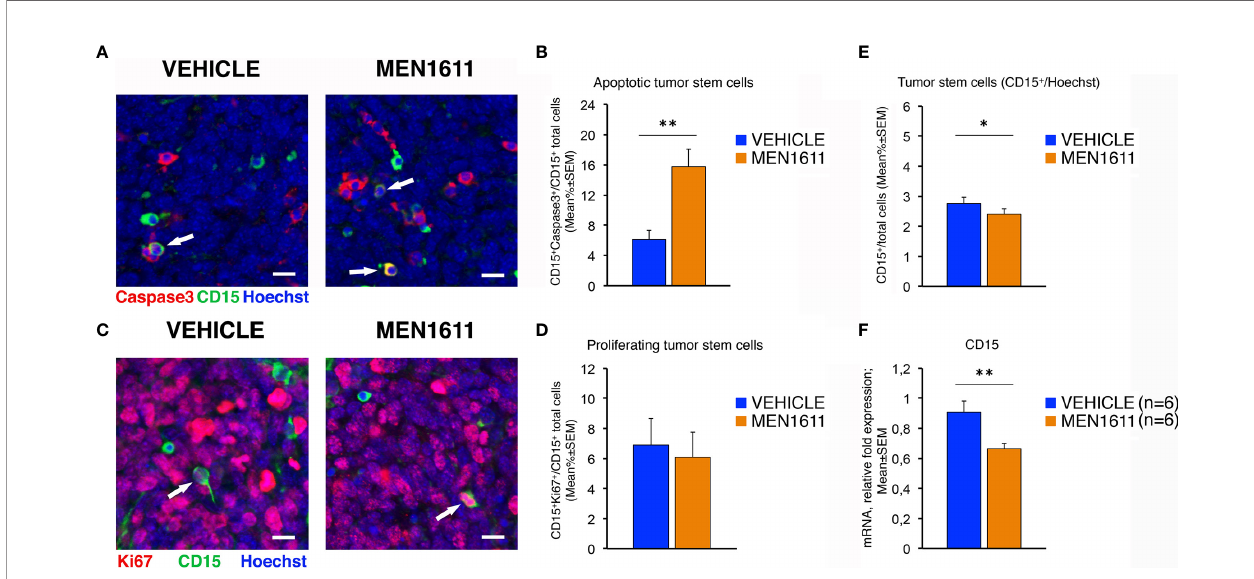
FIGURE 8 | In Ptch1 +/ − /Tis21 KO MB allografts, the treatment with MEN1611 induces the apoptosis of tumor stem cells. (A) Representative confocal images of secondary tumors from Ptch1 +/ − /Tis21 KO MB allograft treated with MEN1611 or vehicle, labeled with cleaved Caspase-3 (red) and CD15 (green) markers, and the nuclei dye Hoechst (blue). The apoptotic tumor stem cells (CD15 + Caspase3 + ) are indicated by white arrows. Scale bar, 10 m m. (B) Apoptotic tumor stem cells in the nodules of MEN1611-treated and vehicle-treated mice were quanti fi ed as mean ± SEM percentage ratio between the number of CD15 + Caspase3 + cells and the total number of CD15 + cells. ** p < 0.01, Mann-Whitney U -test. Mice analyzed: n = 6 for each treatment; fi elds analyzed: n = 144 for vehicle and n = 145 for MEN1611. (C) Representative confocal images of staining of MEN1611-treated and vehicle-treated nodules for Ki67 (red) and CD15 (green) markers. Nuclei were stained with Hoechst 33258. The proliferating tumor stem cells (CD15 + Ki67 + ) are indicated by white arrows. Scale bars: 10 m m. (D) Quanti fi cation of the percentage ratio (mean ± SEM) of CD15 + Ki67 + cells to the total number of tumor stem cells (CD15 + ) in nodules of MB allograft treated with MEN1611 or vehicle. p = 0.7346, Student ’ s t test. Mice analyzed: n = 6 for each treatment; fi elds analyzed: n = 134 for vehicle and n = 146 for MEN1611. (E) Quanti fi cation of the tumor stem cells, identi fi ed as CD15 + (green), in nodules of mice treated with MEN1611 or vehicle, measured as mean ± SEM percentage ratio between the number of CD15 + cells and the total number of cells (Hoechst-positive). The CD15 + cells were counted both in tumor slices reacted with the antibodies against Caspase-3 and CD15 (A) , and in sections labeled with Ki67 and CD15 markers (C) . * p < 0.05, Mann-Whitney U -test. Mice analyzed: n = 6 for each treatment; fi elds analyzed: n = 278 for vehicle and n = 291 for MEN1611. (F) Real-time PCR analysis of CD15 mRNA obtained from MEN1611- and vehicle-treated nodules. Mean ± SEM values are from two independent experiments and are shown as fold change relative to the vehicle-treated nodules (one of them chosen for setting to unit). TBP mRNA was used to normalize data. Six secondary tumors per treatment were analyzed. ** p < 0.01, Student ’ s t